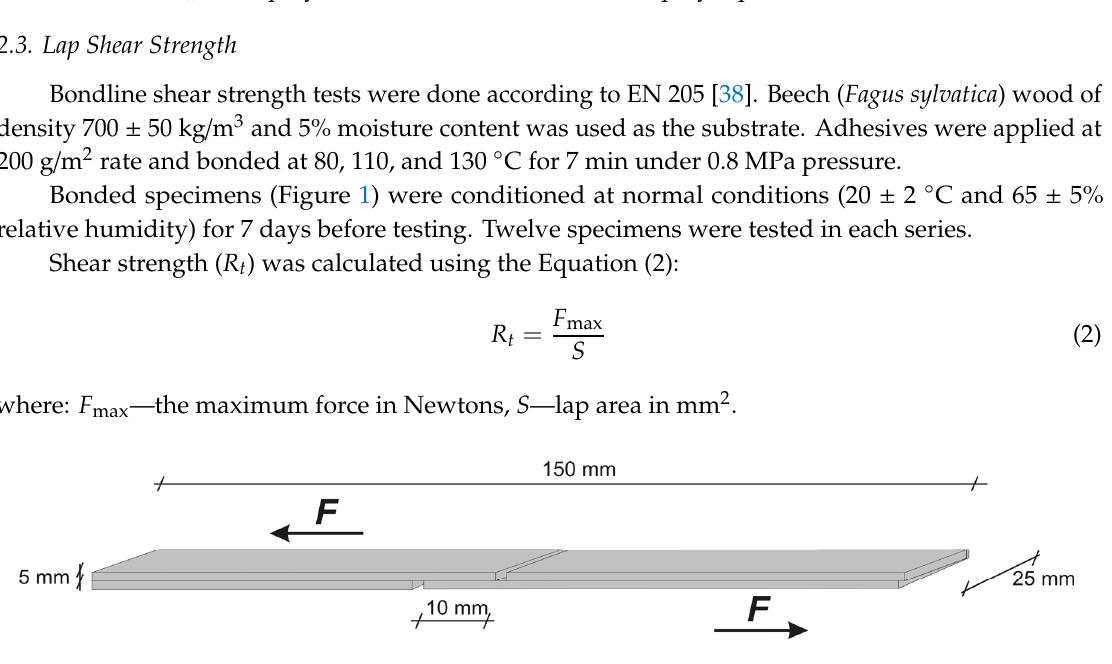
Figure 1. Lap specimen: F— force direction.